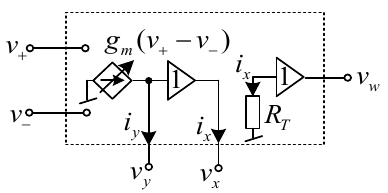
Figure 2. Ideal equivalent circuit of LT1228.